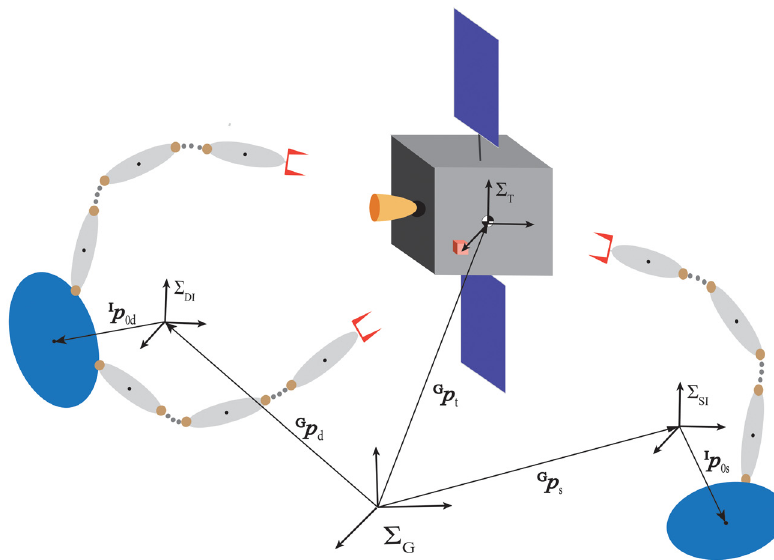
Figure 1: A simpli fi ed model of the cooperative capture system.